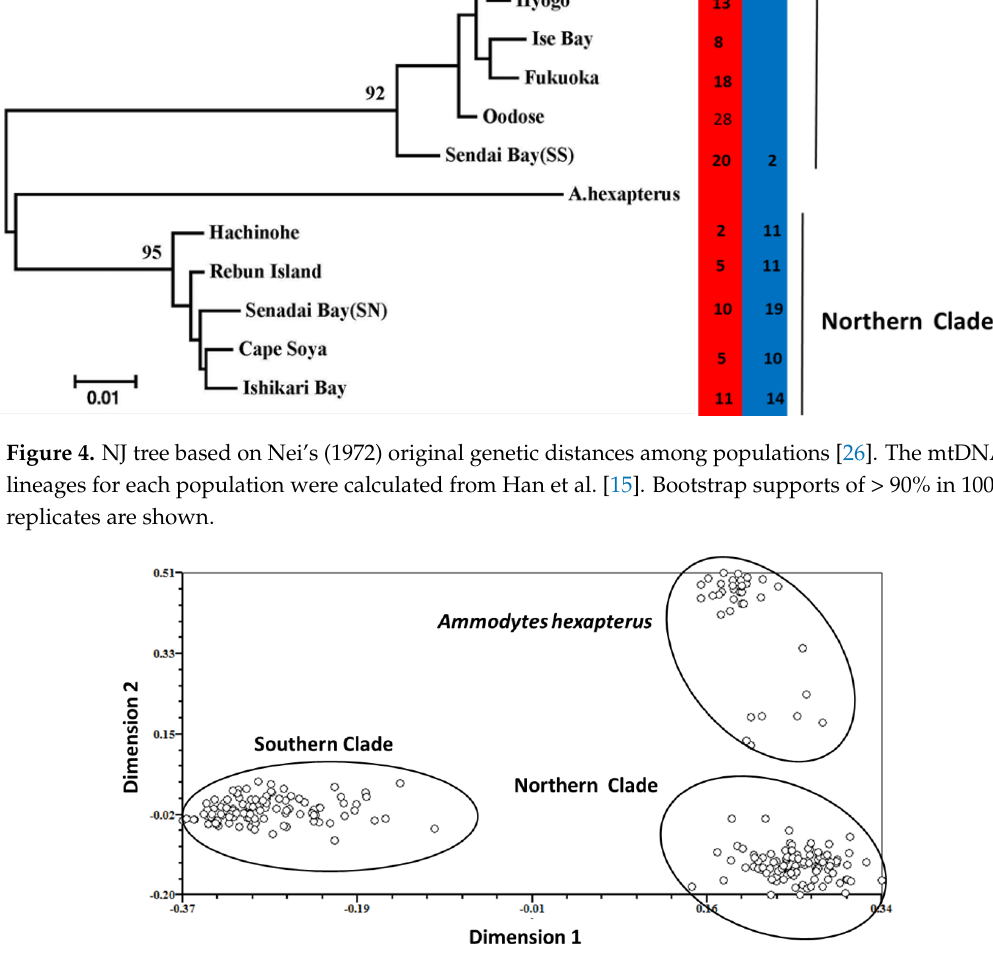
Figure 5. Two-dimensional scaling of two clades by principal component analysis (PCA) using AFLP markers.